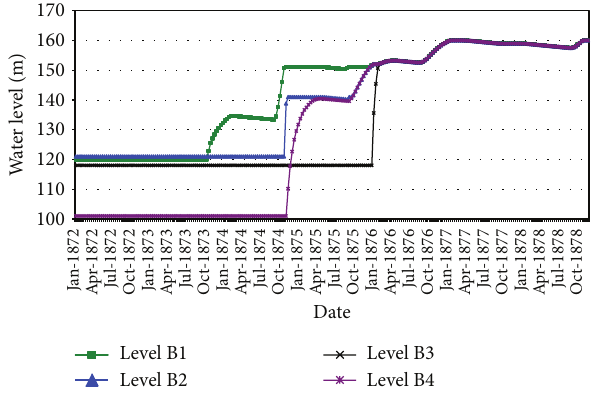
Figure 16: Water levels during the first flood